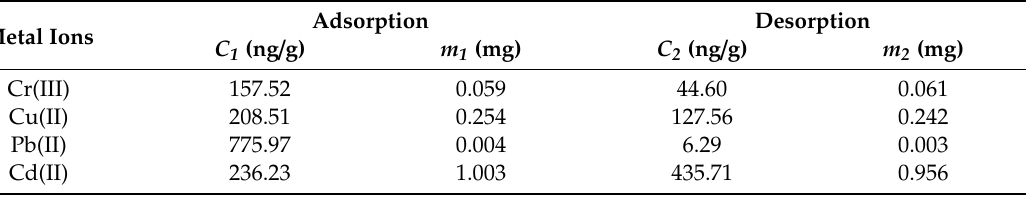
Table 3. Inductively coupled plasma mass spectrometry (ICP-MS) results of adsorption and desorption of various heavy metal ions.